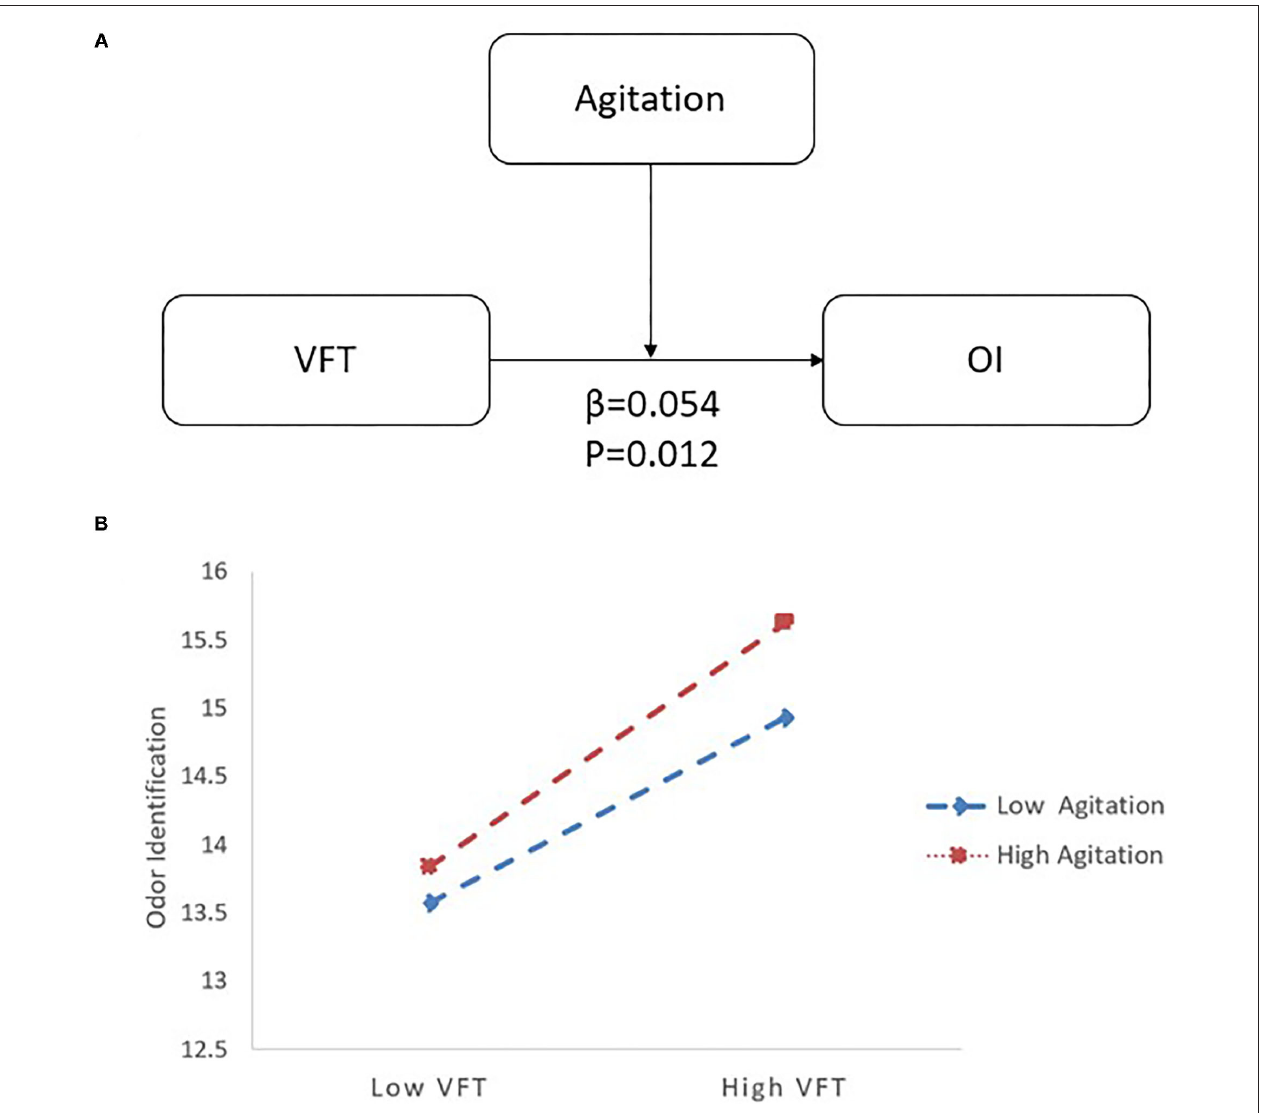
FIGURE 2 | The moderating effect of agitation and VFT on OI with LLD. (A) The interactive model among agitation, VFT and OI. There is an interactive effect of VFT*Agitation ( β = 0.054, p = 0.012) on OI. (B) When agitation increased from low ( − 1 SD; B = 0.108) to high ( + 1 SD; B = 0.305) values, the positive association between VFT and OI became significantly stronger by follow-up simple slope analysis. LLD, late-life depression; VFT, Verbal Fluency Test; OI, odor